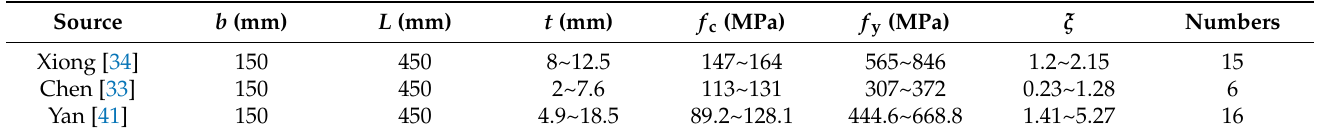
Table 4. The database of rectangular UHPCFST columns subjected to axial compression.